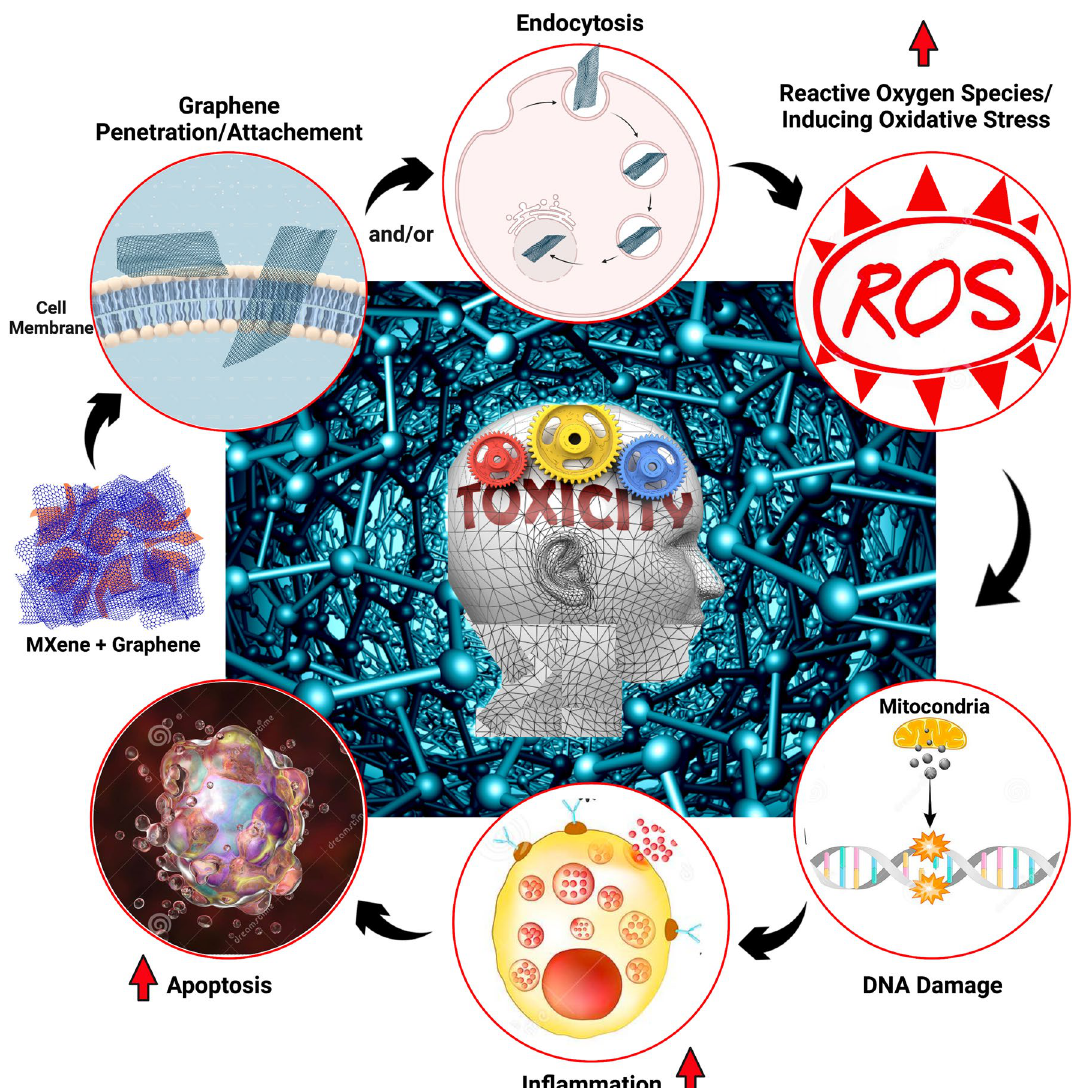
Fig. 5 The potential mechanism of toxicity to human cells upon exposure to graphene-based